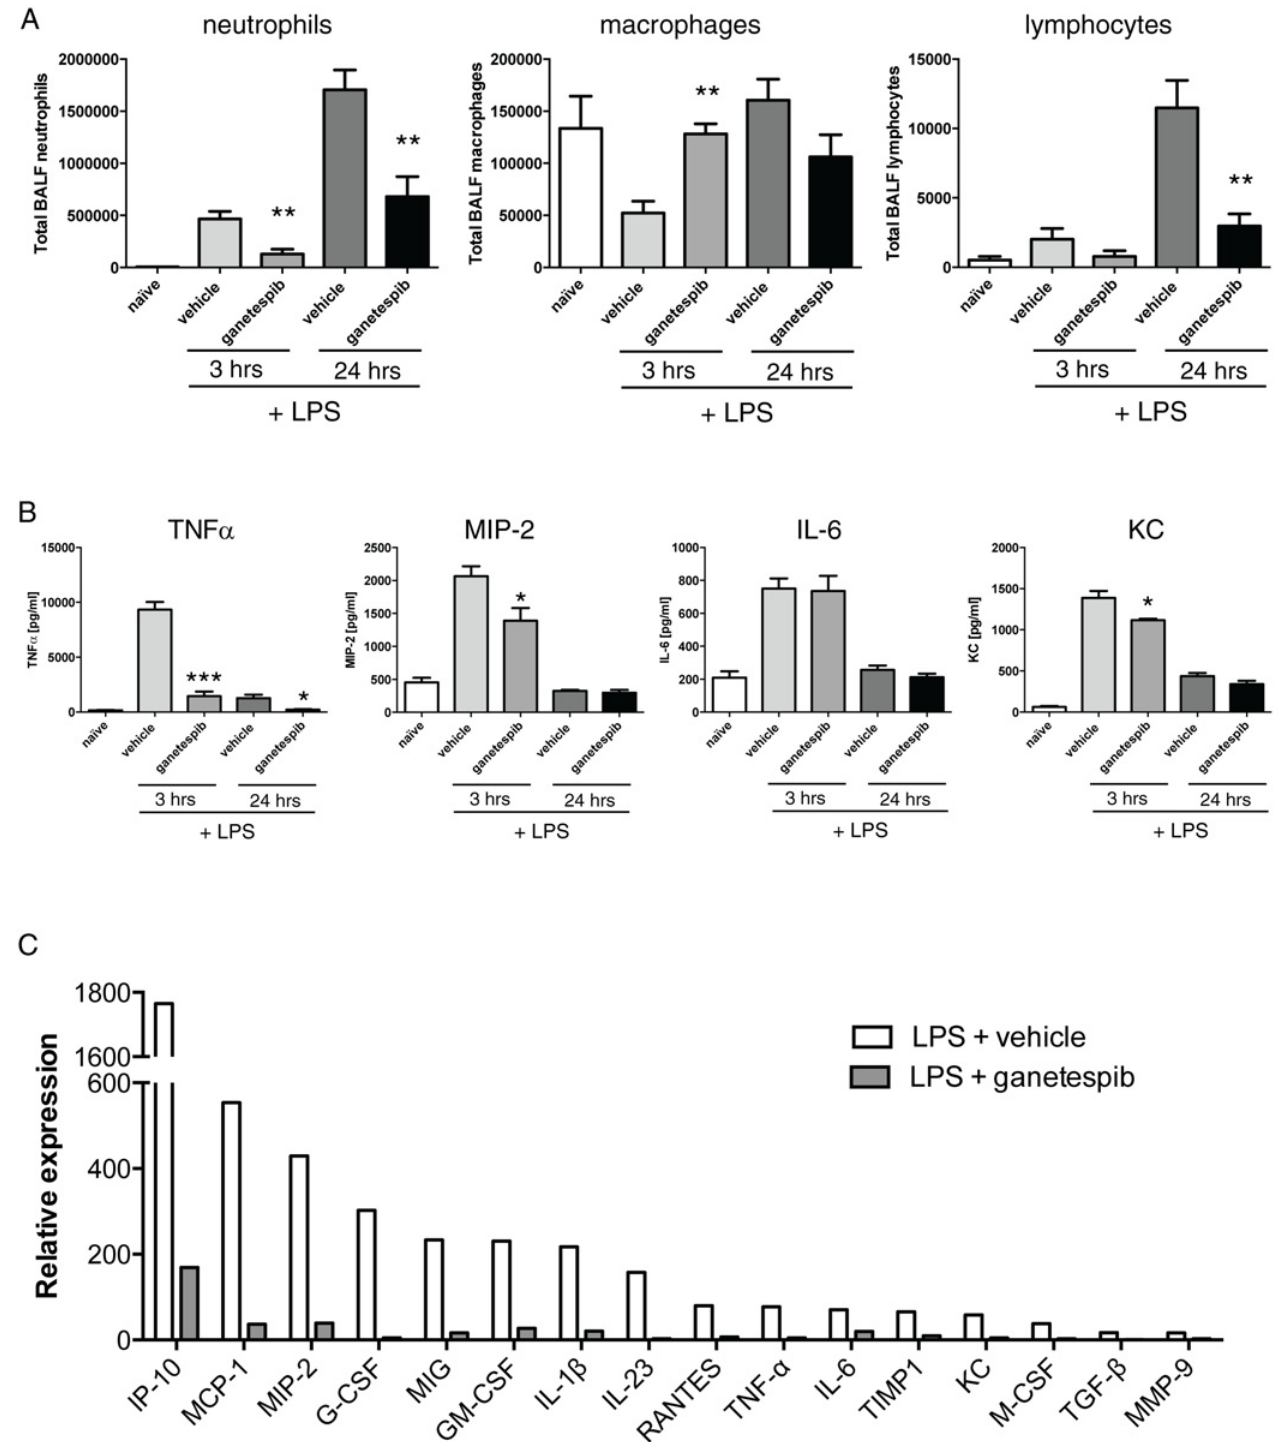
Figure 2. Effect of Ganetespib on cellular inflammation and mediator levels and transcripts. (A) Balb/c mice were treated with Ganetespib (50 mg/kg, i.v. or vehicle) and challenged with LPS (10 µ g/mouse tn). BALF was collected at 3 and 24 h post-LPS and total cells/mL were counted and